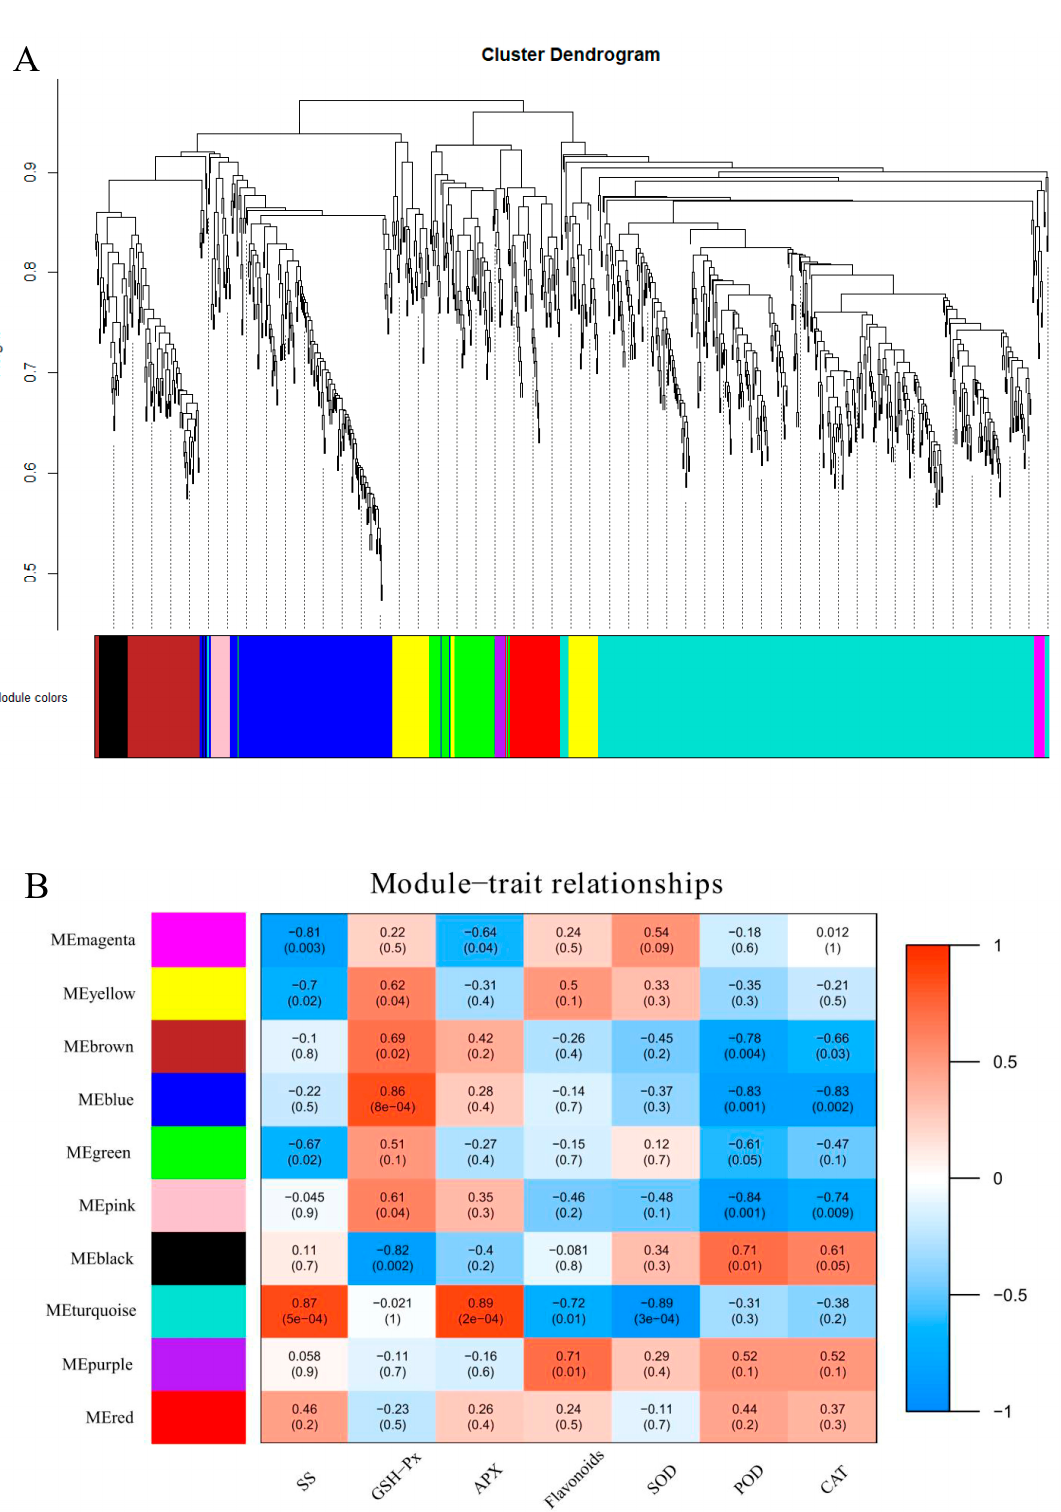
Figure 7. Identification and correlation analysis of WGCNA modules in centipedegrass under low- temperature stress. ( A ) Hierarchical clustering tree of 10 coexpression modules identified using WGCNA. ( B ) Correlation analysis of 10 modules and 7 physiological traits. Correlation coefficients are color-coded from ( − 1) (blue) to (1) (red) and the associated p-values are indicated in parentheses.